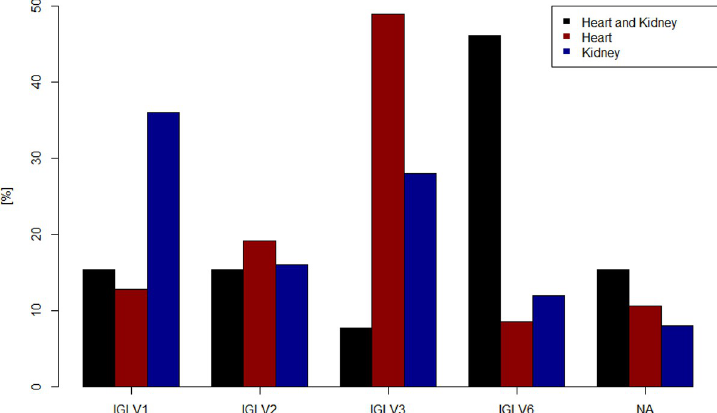
Fig 1. Comparison of the V λ -family expression. Dominant heart and kidney involvement = Heart and Kidney (black), dominant heart involvement = Heart (red), dominant kidney involvement = Kidney (blue).